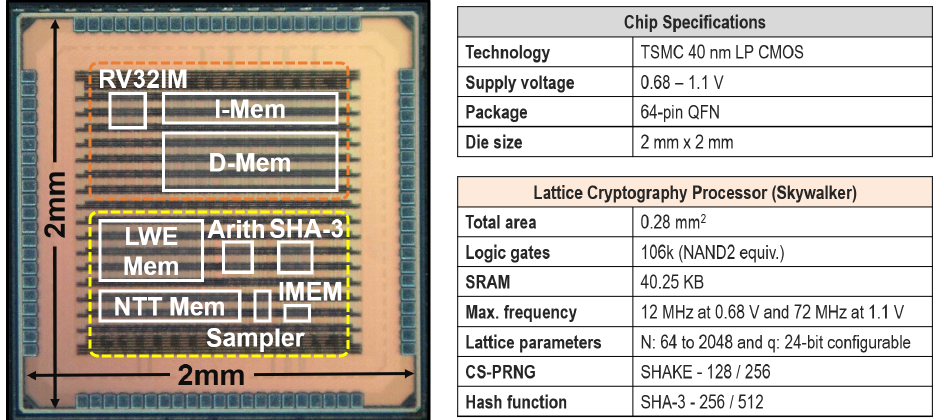
Figure 11: Chip micrograph and test chip